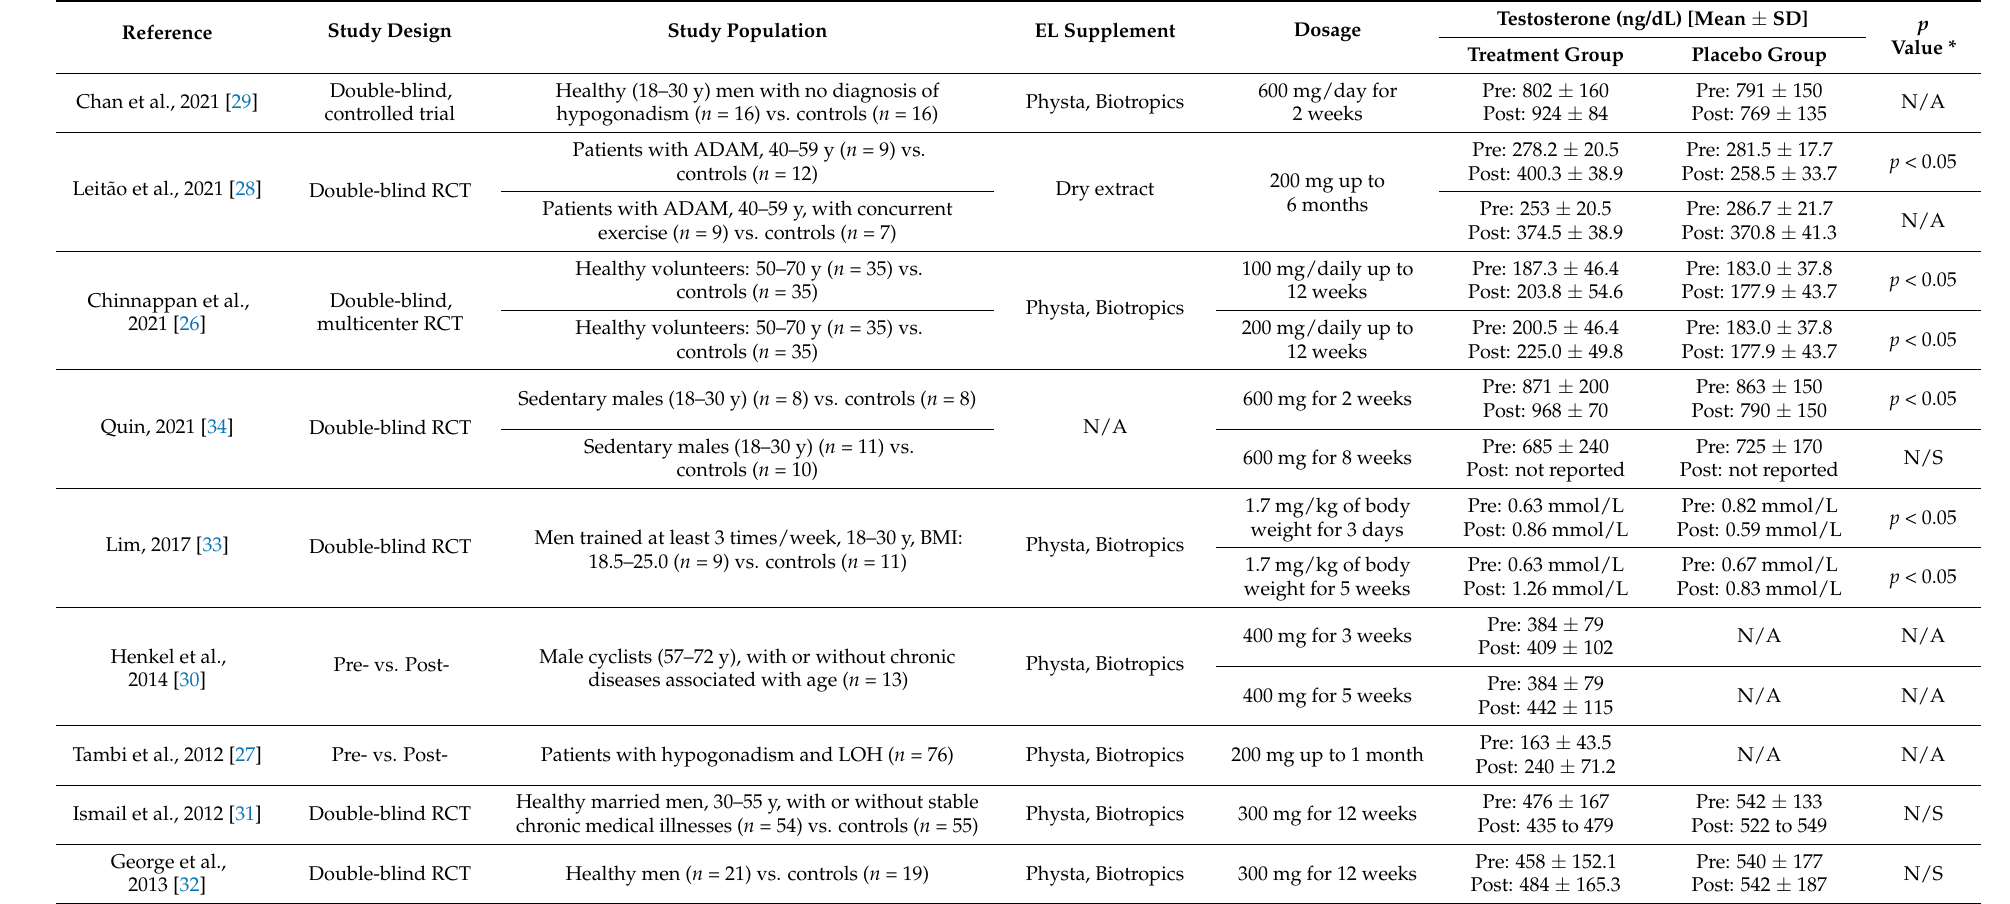
Table 1. Characteristics of the studies investigating the effect of E. longifolia on serum testosterone levels in